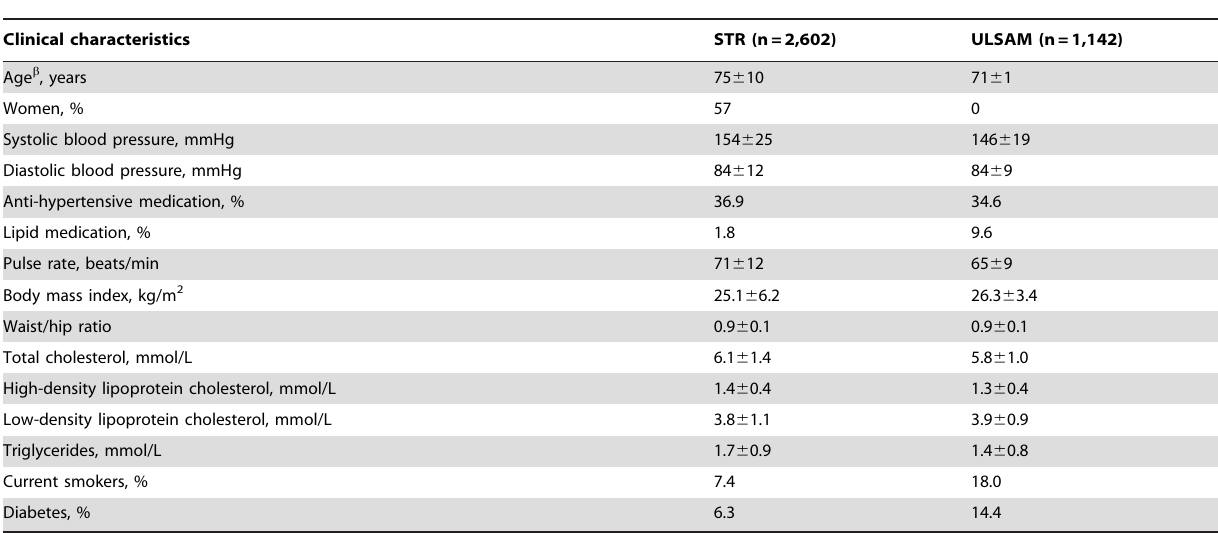
Table 1. Clinical characteristics of the study samples at time of DNA collection a .